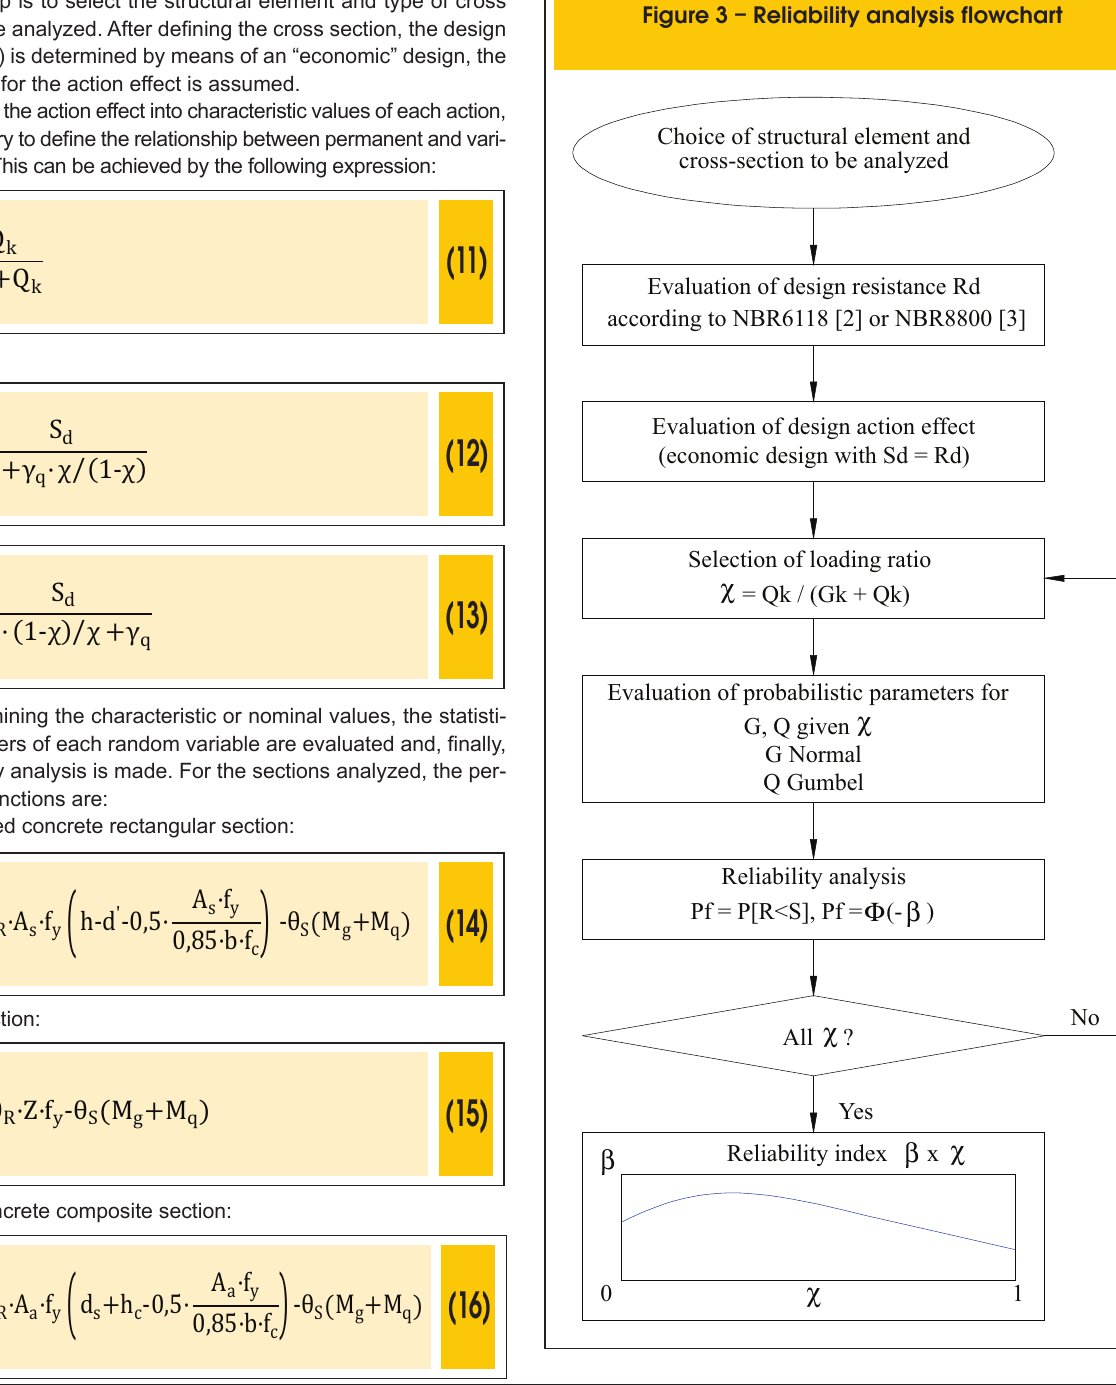
Figure 3 – Reliability analysis flowchart